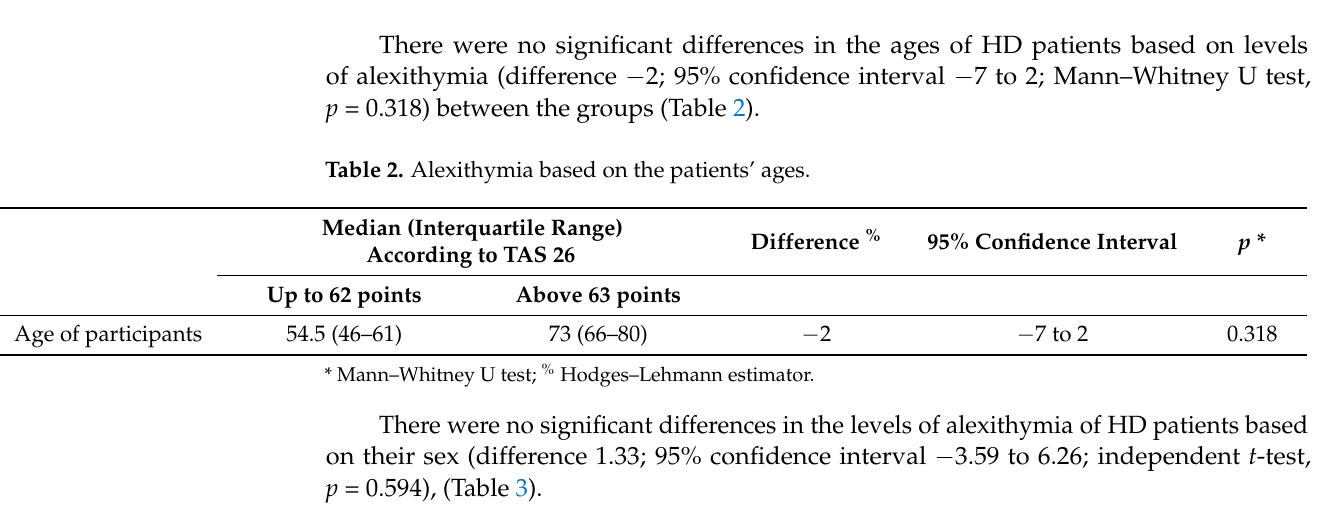
Table 3. Levels of alexithymia based on the patients’